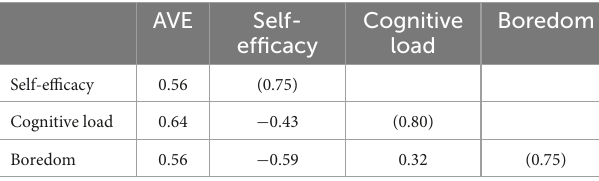
TABLE 4 Discriminant validity of the